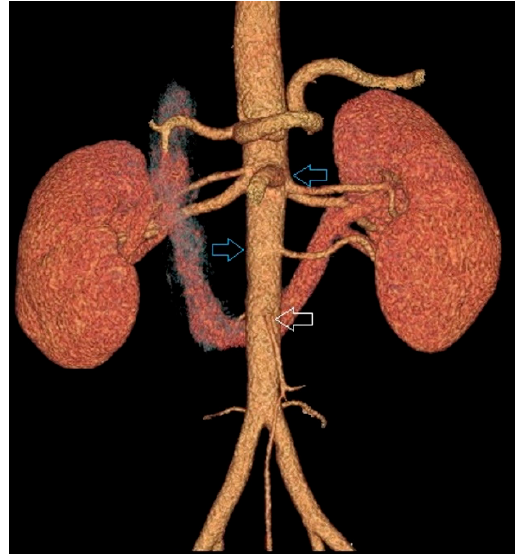
Figure 1. Example of two separated kidneys both supplied by supernumenery renal arteries branching from the aorta above the inferior mesenteric artery.